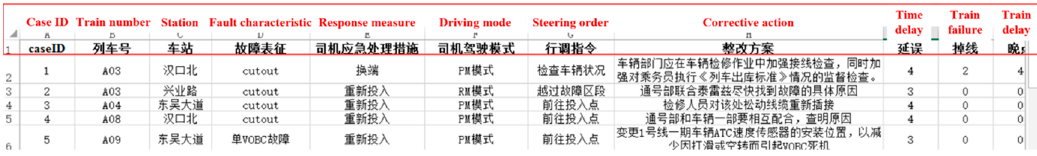
Figure 6. The annotated metro accident cases.